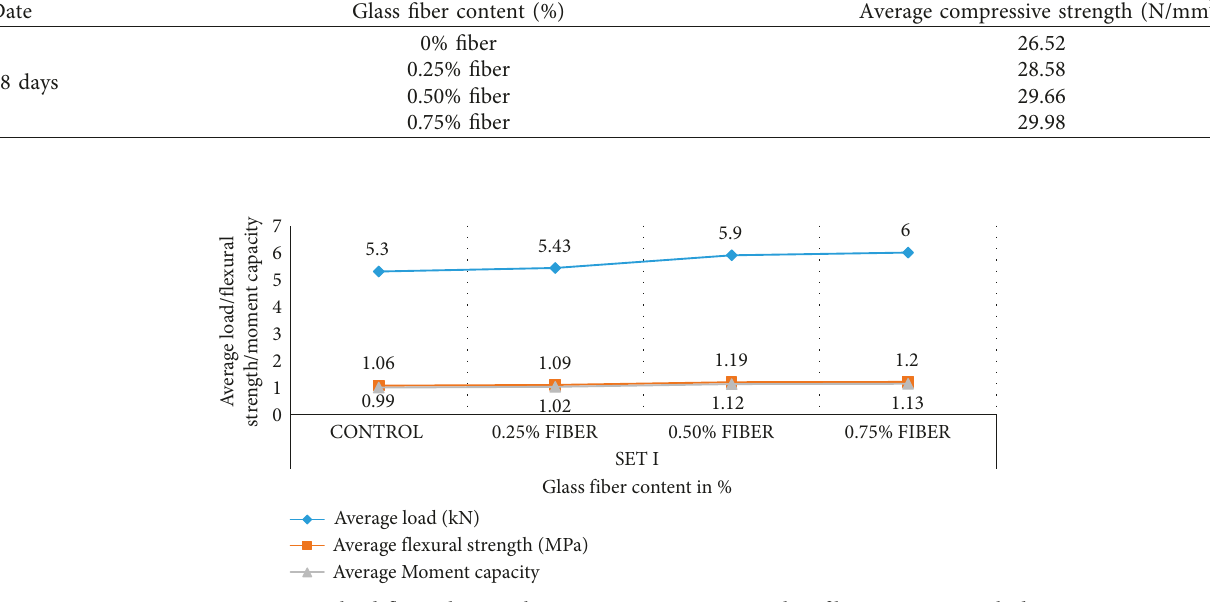
Figure 5: Average load/flexural strength/moment capacity versus glass fiber content on 7th